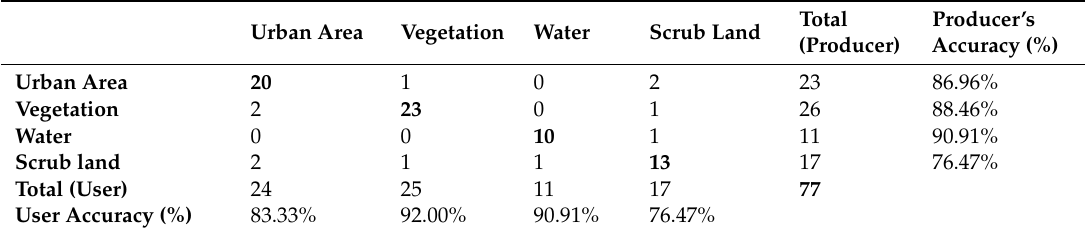
Table A1. Confusion Matrix of LULC map of 2011 using Support Vector Machines (SVM)